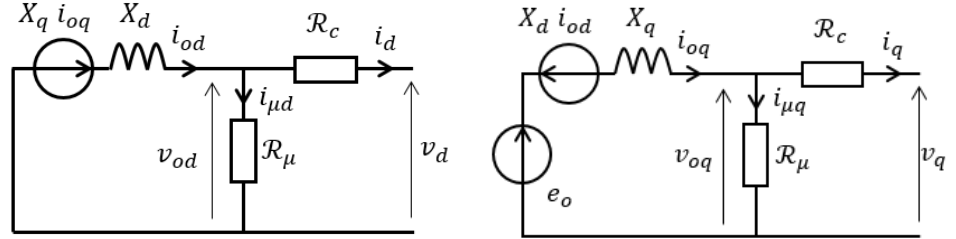
Figure 4. The d and q-axis equivalent circuit.